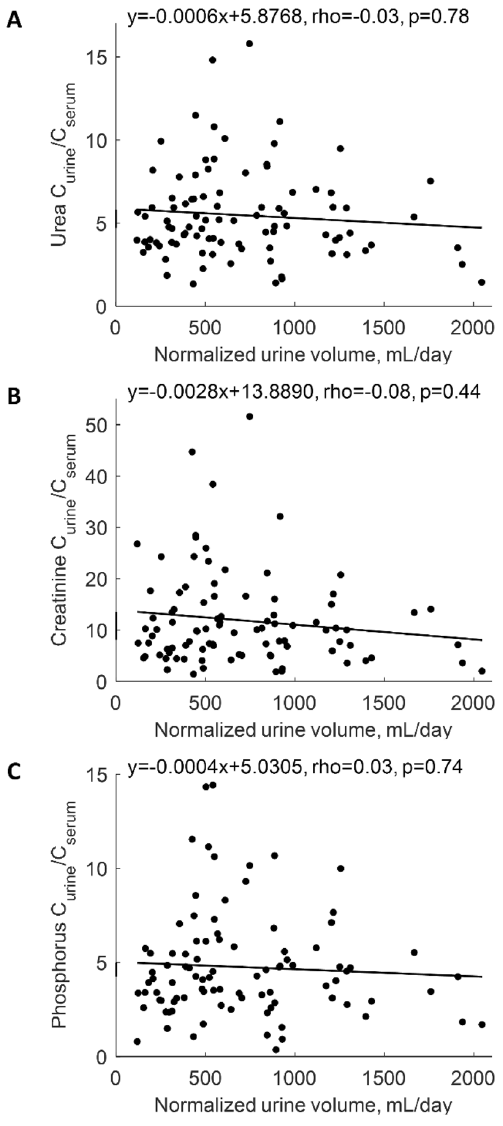
Figure 2. The ratio of the concentration in urine over concentration in serum (C urine /C serum ) for urea (panel A ), creatinine (panel B ) and phosphorus (panel C ) vs. normalized urine volume. Continuous line represents linear regression with equation displayed on the